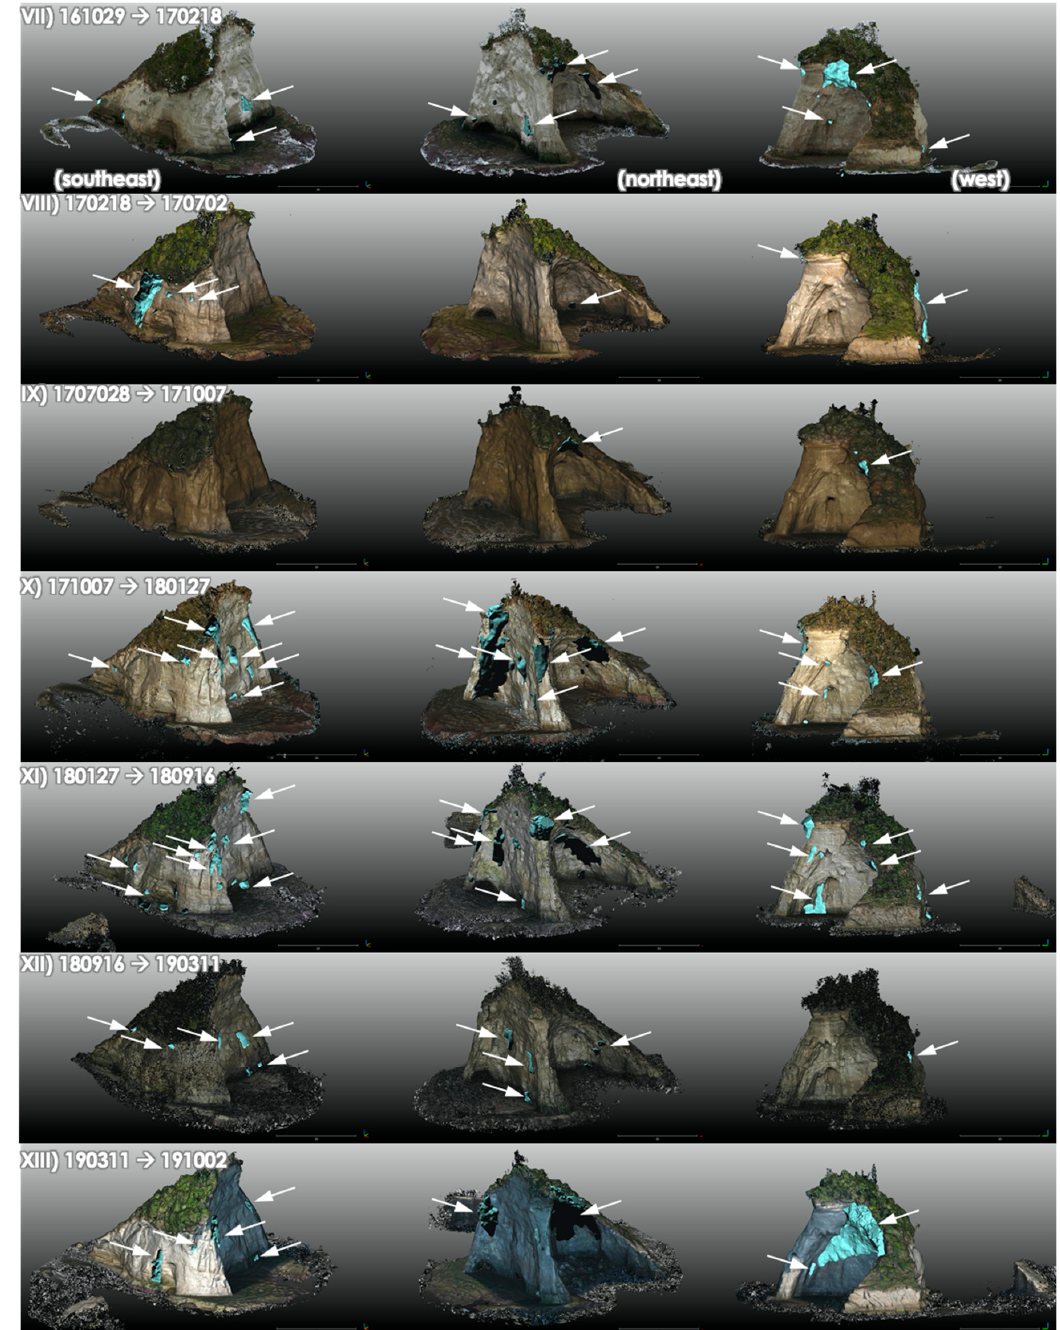
Figure 6. Cont. Figure 6. Di ff erential volume estimate (DVE) for each time period, showing the eroded area of the bedrock cli ff s by comparing the point clouds taken in di ff erent time periods. Changed areas are highlighted with white